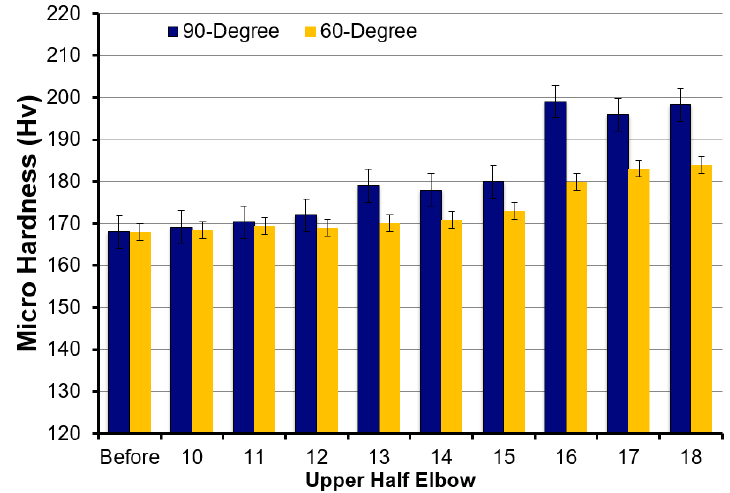
Figure 14. Microhardness of carbon steel elbows’ upper half sections before and after the